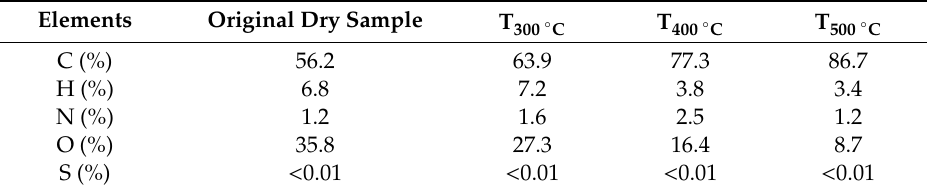
Table 2. Ultimate analysis for the di ff erent process temperatures.